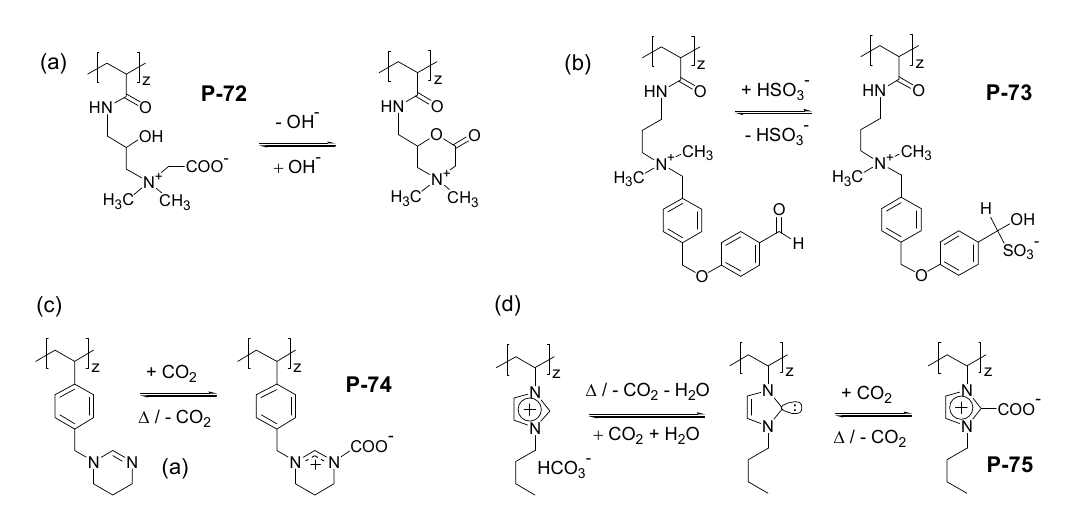
to amidines [441] 2